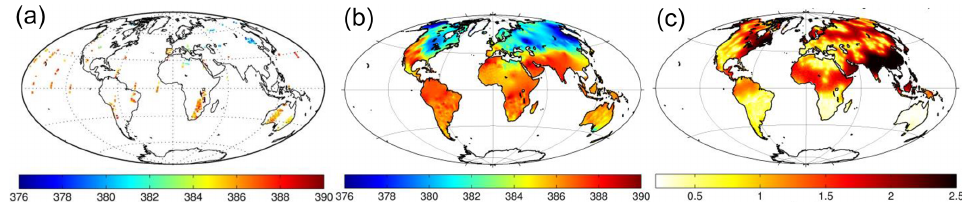
Figure 3. (a) GOSAT/ACOS v3.4 XCO 2 retrievals (Level 2 data) (ppm) for 3 August 2009. (b) Contiguous global GOSAT/ACOS v3.4 maps (Level 3 data) (ppm) for the same day obtained using spatio-temporal moving window block kriging at 1 × 1 ◦ spatial resolution. (c) Associated uncertainties, given as 1 σ ( σ ˆ z )